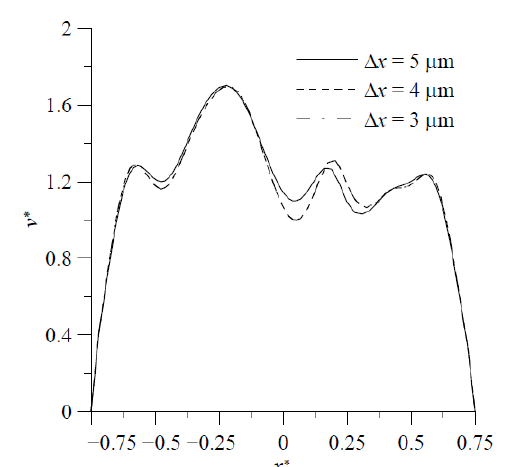
Figure 4. Profiles of velocity component v along the x direction on the middle horizontal on the cross-section at y = 120 µ m obtained by using various grid sizes.